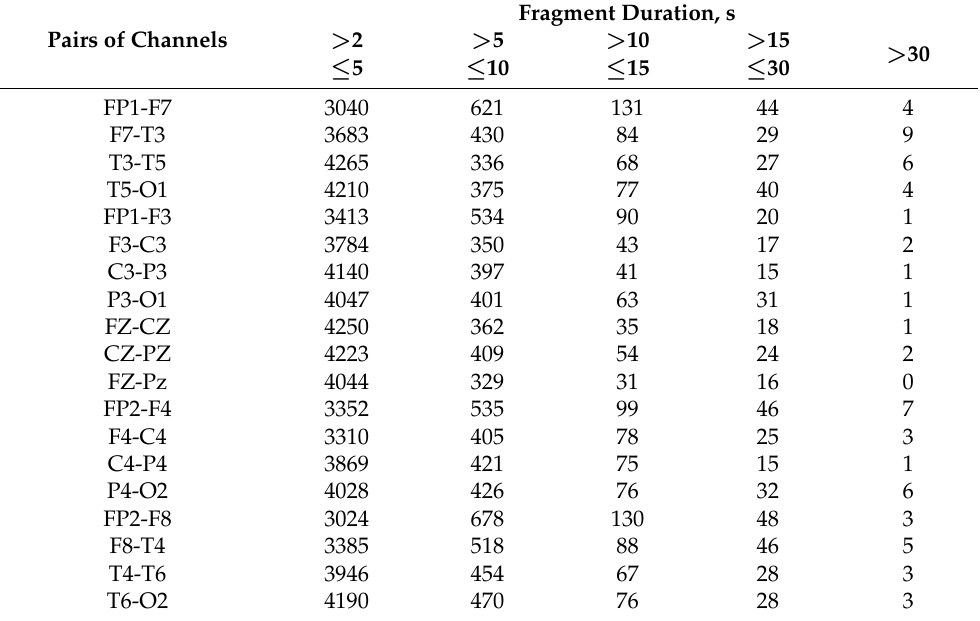
Table 1. Histogram of the number of synchronized fragments depending on the duration in 19 pairs of EEG